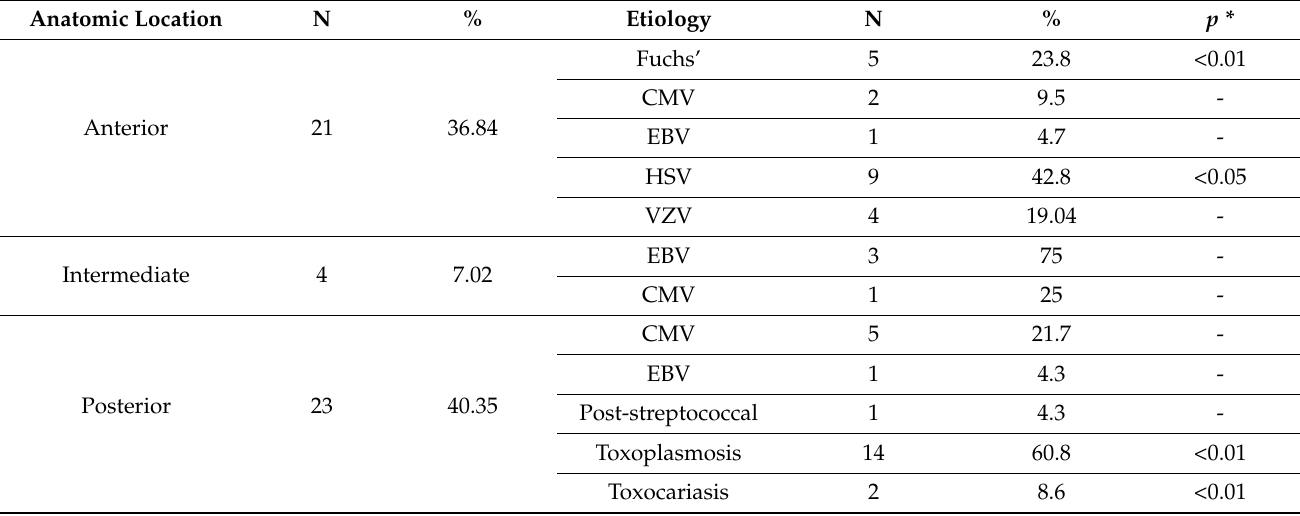
Table 3. Anatomical location of uveitis and the associated